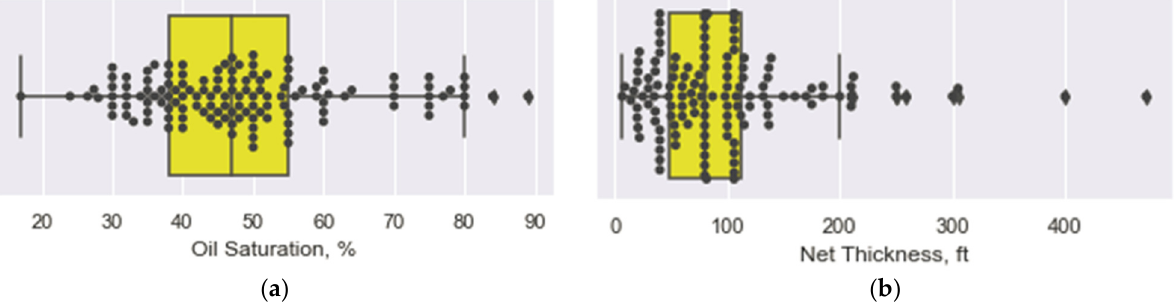
Figure 11. Miscible CO 2 -EOR box plot and swarm plot: ( a ) oil saturation and ( b ) net thickness.